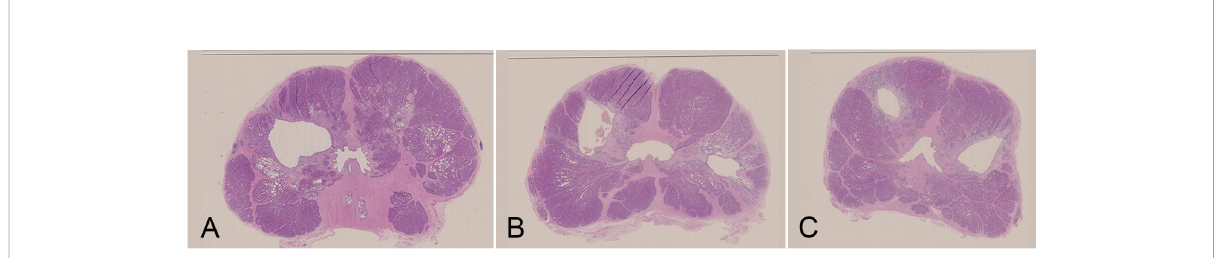
FIGURE 4 Tissue defects developed 4 weeks after intraprostatic injection of absolute ethanol. (A) 2 mL (left) and 0.5 mL (right), (B) 2 mL (left) and 1 mL (right), (C) 1.5 mL on both sides. Tissue defects are lined with epithelium and surrounded by connective tissue with signs of fi brosis. The area of the prostatic pseudocapsule shows no